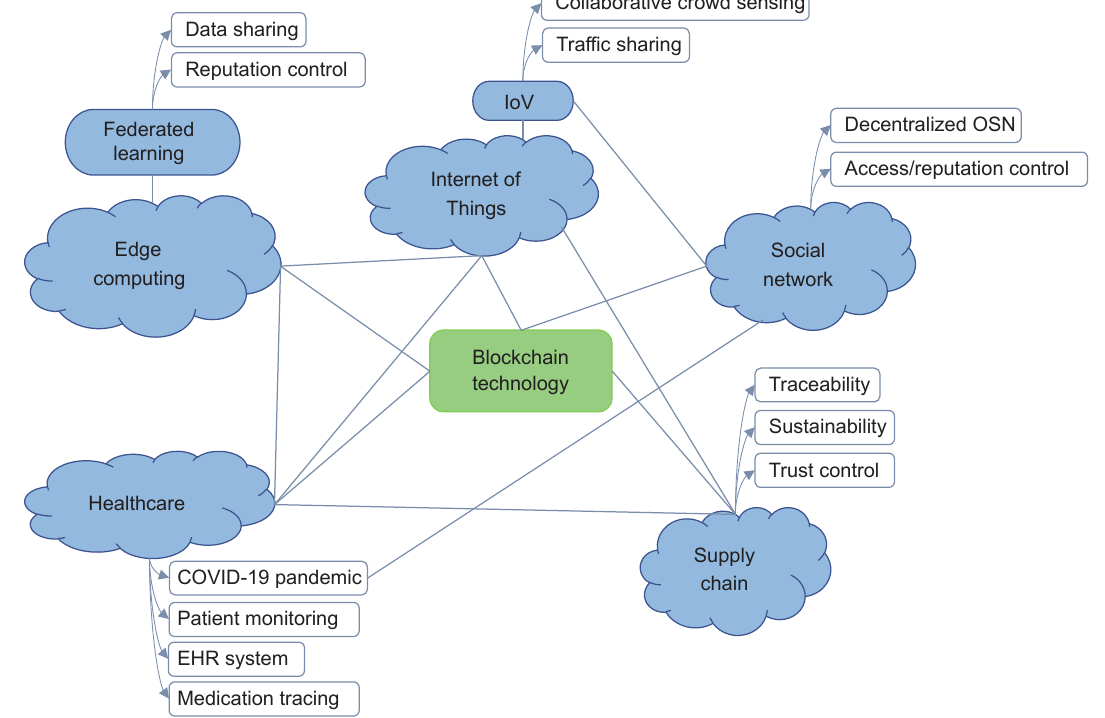
Fig. 1 Blockchain ecosystem in this